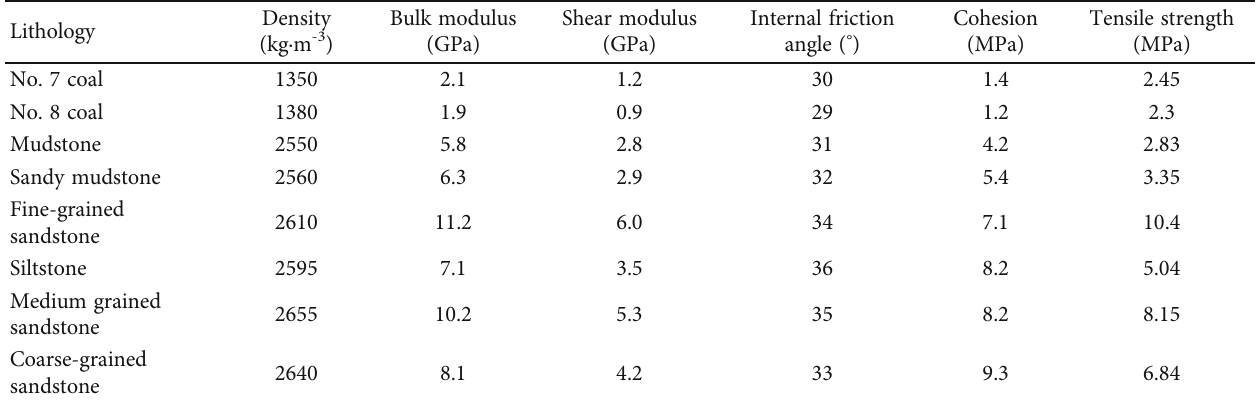
Table 1: Main coal and rock mechanical parameters.